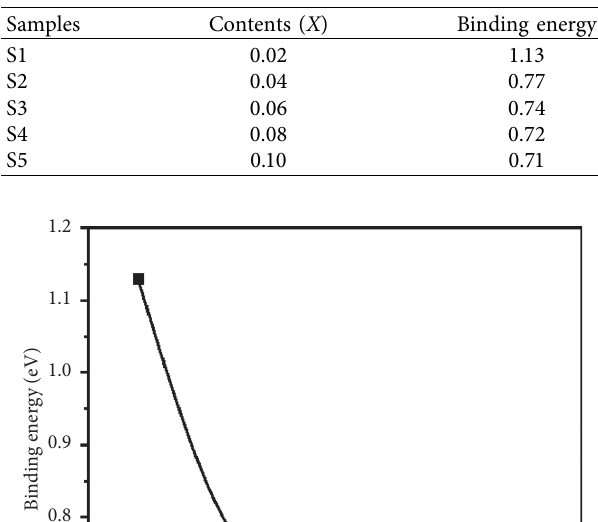
� 0.02 to 0.08 and y � 0.2 to 0.8). 1 − x La x Mn y Fe 12 − y O 19 ( x Table 2: Concentration and binding energy of hexaferrites through the Tauc plot have been calculated.